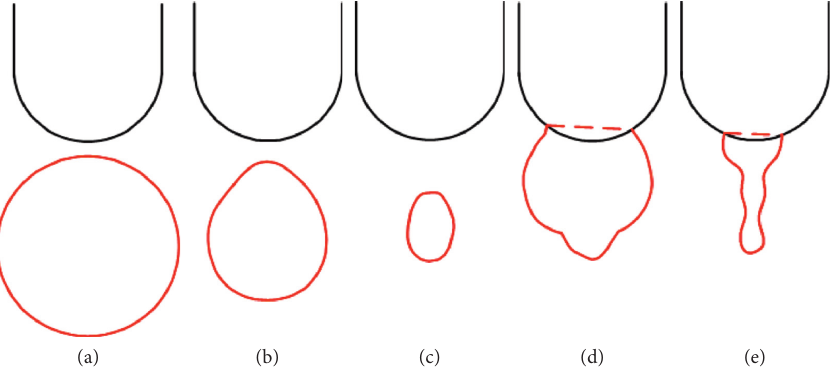
Figure 21: Description of drop-like bubble morphological characteristics. (a) First maximum volume. (b) Drop-shaped bubble. (c) First minimum volume. (d) Second maximum volume. (e) Second minimum